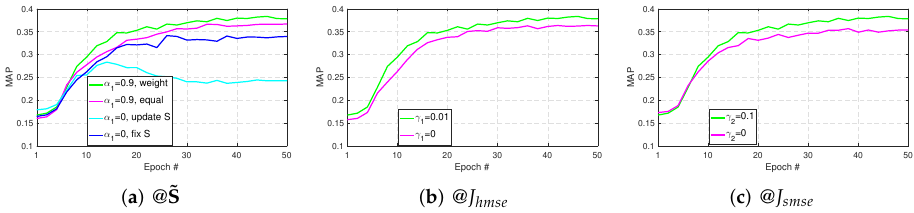
Figure 2. Ranking performance in terms of MAP of UDPH with different settings on different training epochs at 32-bit on CIFAR-10 using VGG-16 as the backbone: ( a ) different settings of ˜S , ( b ) with/without the term J hmse in Equation (5), ( c ) with/without the term J smse in Equation